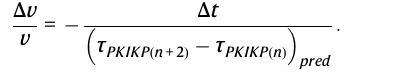
Weusethebootstrapmethod(Fig.S9)toestimatetheuncertainty of the residual measurements for the network con fi guration with 5000 shuf fl es of the stations in the stacked waveforms with replace- ments, whose mean and standard variation are measured (shown on top of all panels of Fig. 6).